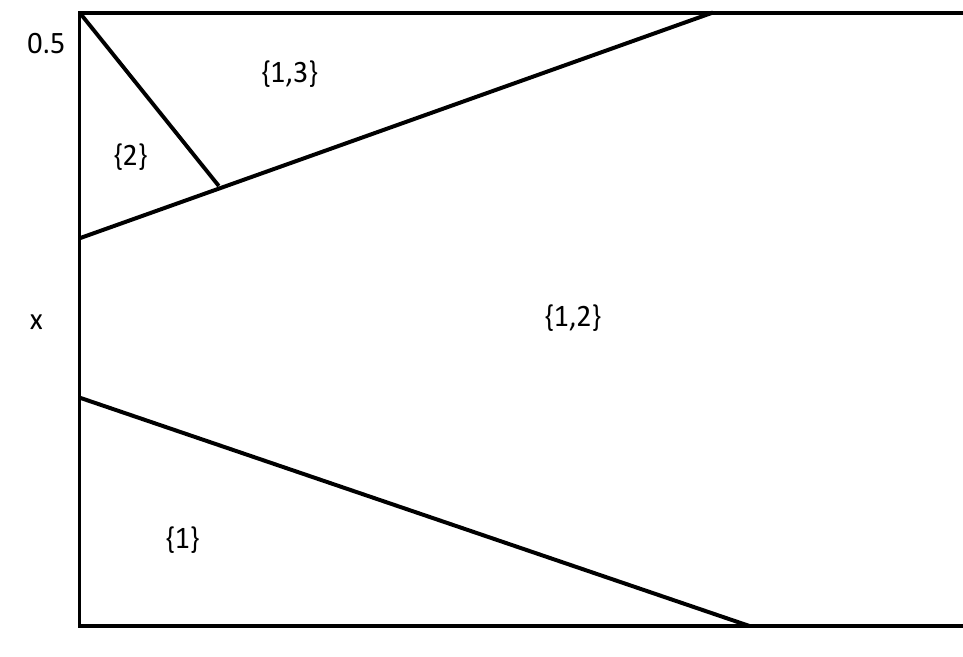
Figure 2. Coalitions with 1 as formateur.